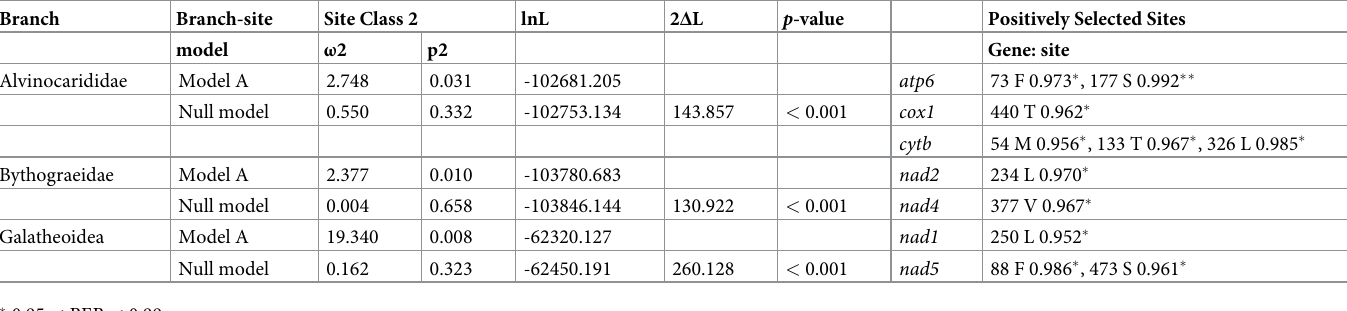
Table 2. The positively selected sites of concatenated analyses (Conc) (branch-site model). Parameter estimates are shown only for the positive-selection site class (Site Class 2). Results of gene-specific analyses under the branch-site model are provided in S3 Table.